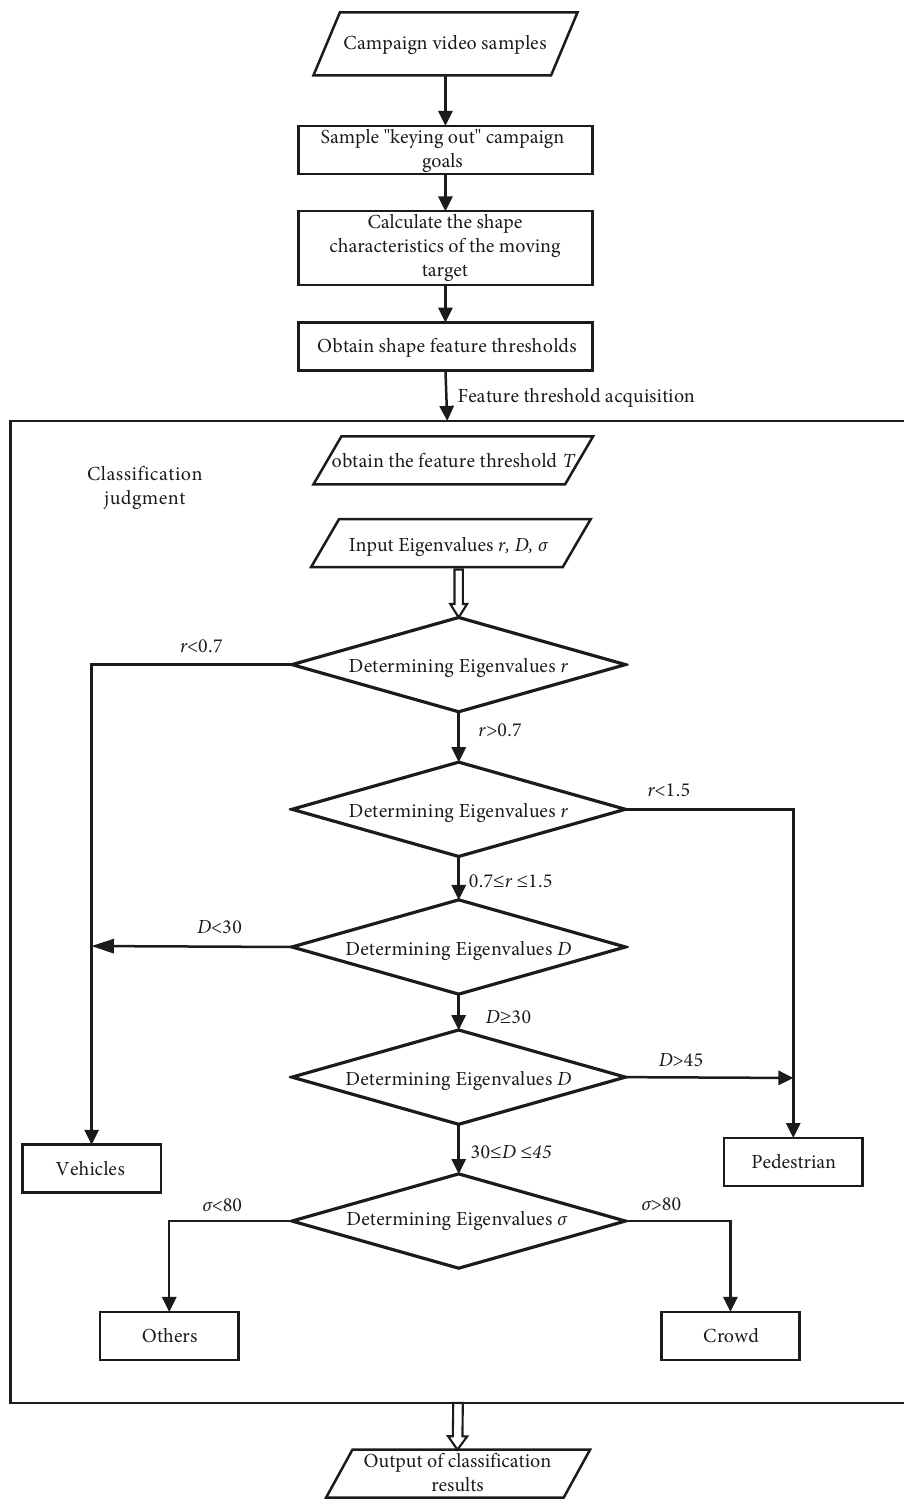
Figure 4: Image classification